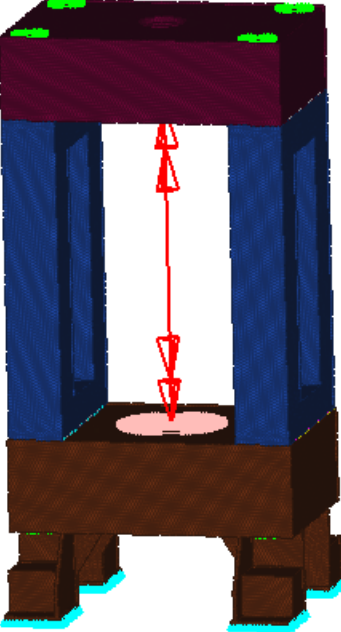
Figure 7. Frame model with nominal force applied.